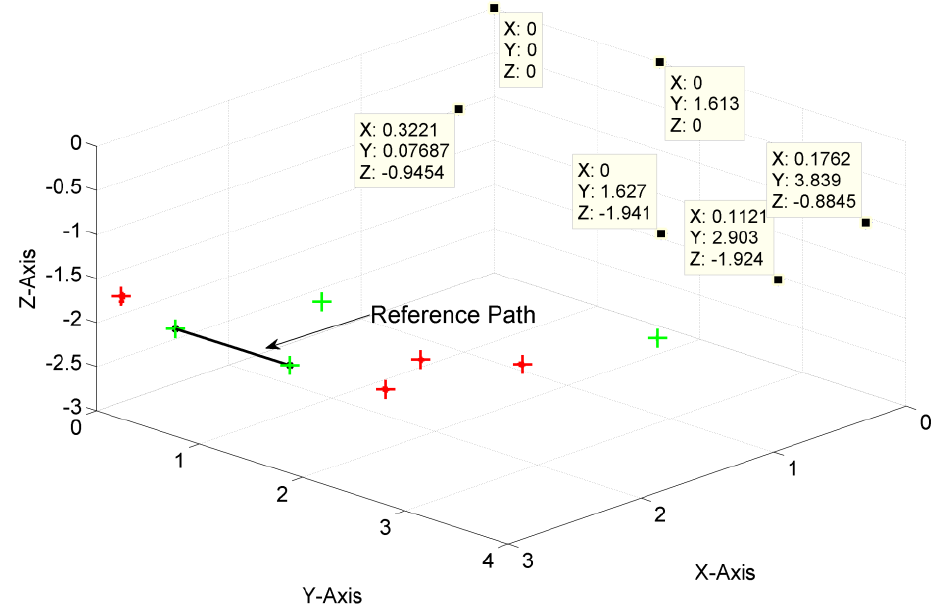
Figure 15. Calibration result (a = 1.012, time delay cone = 81.2 µs, c = 347.3 m/s).